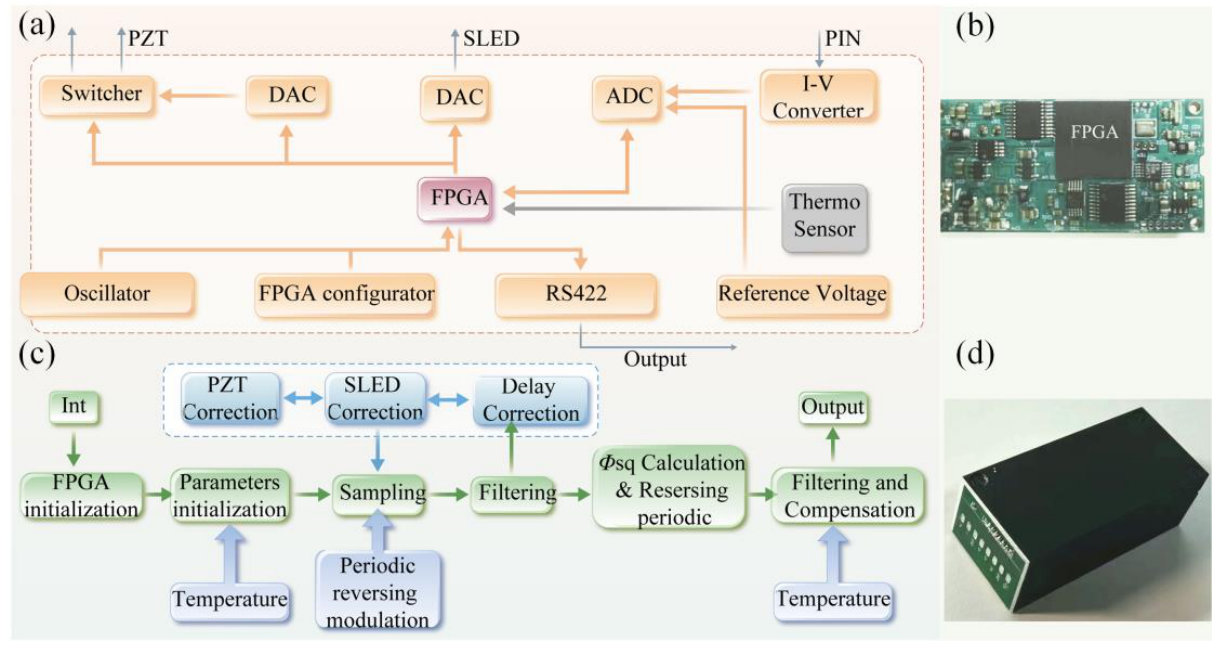
Figure 5. ( a ) Circuit hardware diagram, ( b ) picture of the circuit hardware, ( c ) software process of FOG, and ( d ) picture of the FOG.